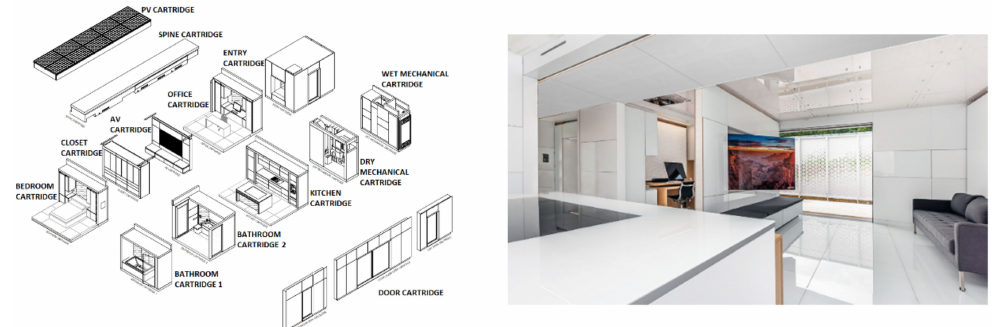
Figure 10. FutureHAUS. ( Left ): Suite of cartridges. Adapted from ref. [47]. ( Right ): Office and living room flex-space with rotating audio-visual (AV) wall, which could be moved mechanically. Reprinted from ref.